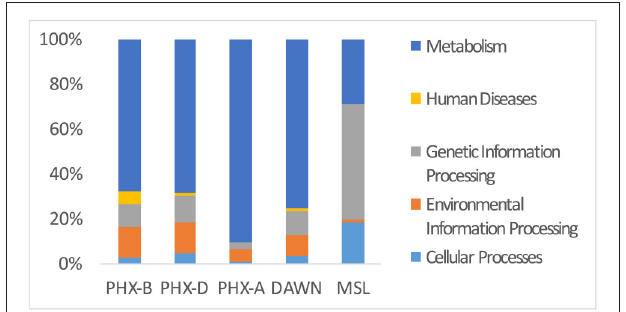
FIGURE 3 | Metabolic genes cover majority of functional classifications. KEGG Pathway analysis of PHX-B, PHX-D, PHX-A, DAWN and MSL. During assembly of PHX-D and DAWN, we see that a bigger fraction of all classified sequences have been assigned to metabolism. See Presentation S2 in Supplementary Material for more